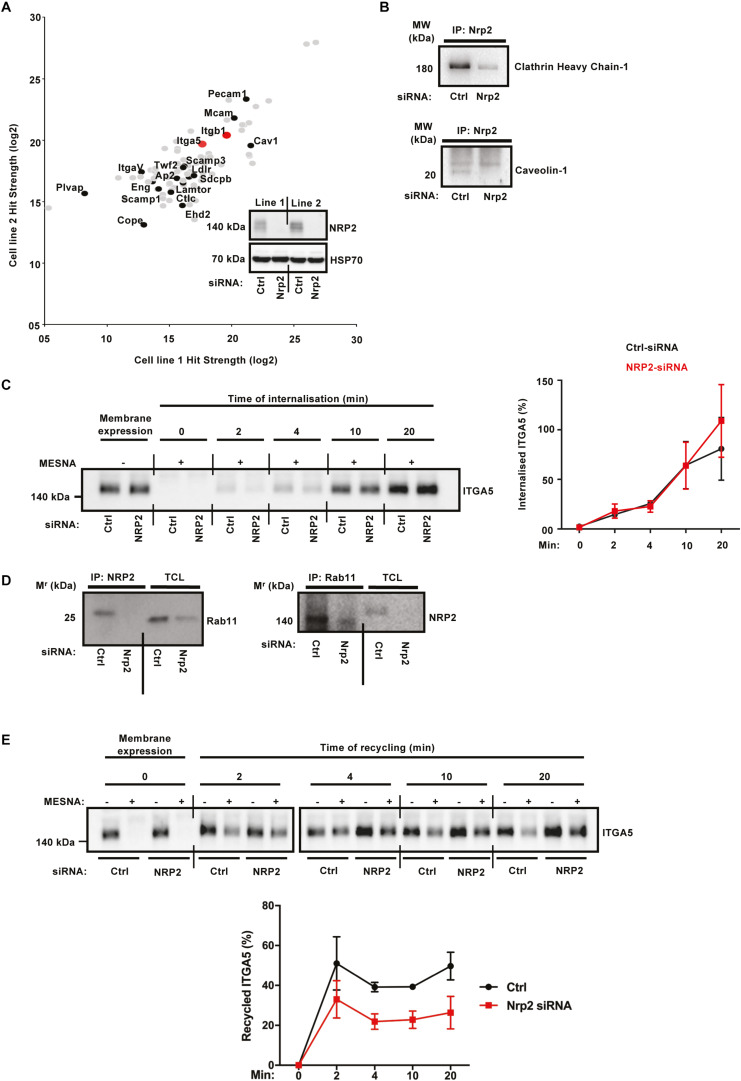
ITGA5 trafficking in ECs is NRP2 dependent. (A): Label-free quantitative mass spectrometry peptide hits identified using MaxQuant software from the Andromeda peptide database. Panel depicts peptide hits detected at a higher fold-change in two control siRNA treated EC lines than those detected from two NRP2 siRNA treated EC lines. NRP2 silencing was confirmed by subjecting EC extracts to Western blot analysis. (B): siRNA-transfected ECs were seeded onto FN and incubated for 48 h. EC extracts were immunoprecipitated by incubation with protein-G Dynabeads® coupled to a NRP2 antibody. Immunoprecipitated complexes were subjected to Western blot analysis using antibodies against clathrin heavy chain-1 (top) and caveolin-1 (bottom). (C): siRNA-transfected ECs were seeded onto FN and incubated for 48 h. ECs were subsequently starved in serum-free media, before being placed on ice. EC cell surface proteins were labeled with 0.3 mg/ml biotin. ECs were then incubated for the indicated timepoints at 37°C, 5% CO2. A sample of ECs were maintained at 4°C as (±Mesna) controls. Following incubation at 37°C, ECs were placed on ice and incubated with 100 mM Mesna. EC lysates were then immunoprecipitated with protein-G Dynabeads® coupled to an anti-biotin antibody. Immunoprecipitated biotin-labeled proteins were separated by SDS-PAGE and subjected to Western bolt analysis. The level of internalized ITGA5 at each time of incubation was normalized to the (-) Mesna control. Left panel shows Western blot image, right panel shows the mean densitometric analysis obtained using ImageJTM. Also shown is confirmation of NRP2 silencing. N = 3 independent experiments. (D): Co-immunoprecipitation study as described in (B), immunoprecipitated complexes were subjected to Western blot analysis using anti-Rab11 and anti-NRP2 antibodies, respectively. (E): siRNA-transfected ECs were prepared as described in (C), after biotin surface labeling, ECs were incubated in serum free media for 20 min at 37°C to allow for internalization. A sample of ECs were maintained at 4°C for use as positive/negative controls. The remaining ECs were then placed on ice, and any un-internalized biotin-labeled proteins stripped off using 100 mM Mesna. The internalized protein fraction was allowed to recycle by incubating the ECs for the indicated timepoints at 37°C. ECs were then returned to ice and incubated in 100 mM Mesna. No Mesna treatment dishes at each timepoint were used as comparative controls. All subsequent stages were performed in the same manner as described in (C), the level of the recycled ITGA5 was determined by normalizing the amount of ITGA5 quantified from dishes treated with Mesna to the total ITGA5 on the membranes of the Mesna-untreated cells in the same period of incubation. N = 3 independent experiments.